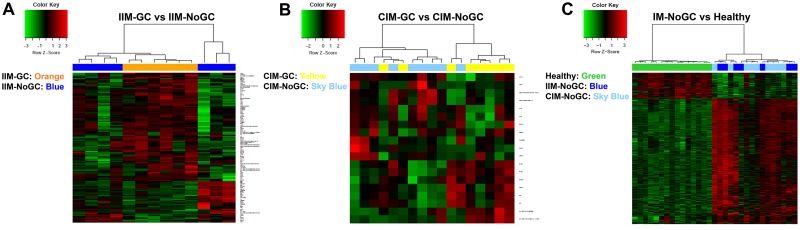
Heat maps of the analyzed groups.A) IIM-GC vs IIM-NoGC, B) CIM-GC vs CIM-NoGC, C) IM-NoGC vs Healthy.